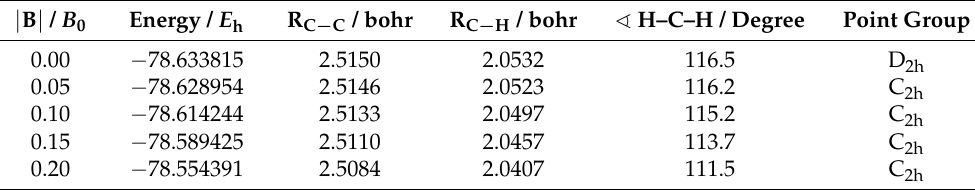
Table 4. Equilibrium geometries of C 2 H 4 at the magnetic field strengths considered in this work, optimized with the cTPSS functional and in the u-aug-cc-pVTZ basis. In all cases, the magnetic field is aligned parallel to the C–C